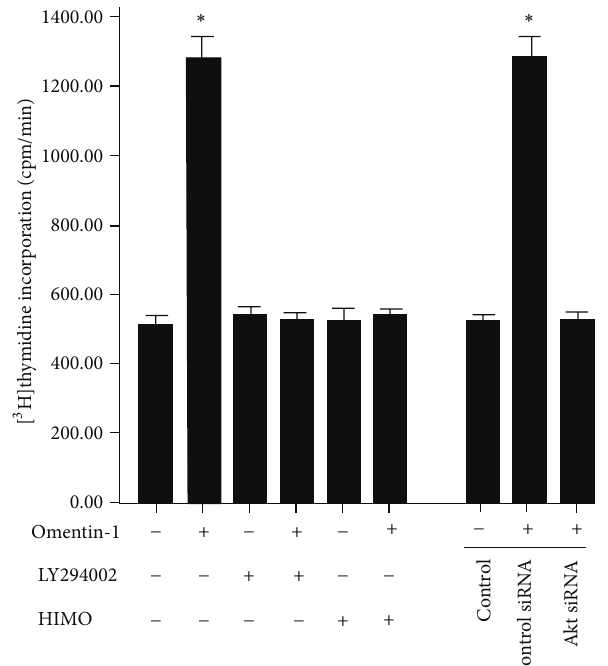
Figure 3: Omentin-1 regulated proliferation of hOB through the PI3K/Akt signaling pathway. The hOBs were pretreated with vehicle, PI3K inhibitor LY294002 (10 𝜇 M), or Akt inhibitor HIMO (10 𝜇 M) for 3h prior to treatment with omentin-1 (200ng/mL) for 48 h. The cells were also transfected with control siRNA or Akt siRNA before treatment with omentin-1 (200 ng/mL) for 48h. Cell prolifer- ation was determined by measuring [ 3 H]thymidine